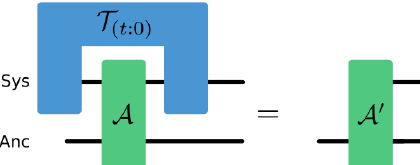
FIG. 15. Complete positivity and trace preservation for super- channels. A superchannel is said to be CP if it maps CP maps to CP maps (even when acting on only a part of them), and we call it CPTP if it maps CPTP maps to CPTP maps. Here, T ( t :0 ) is CP (CPTP) if for all CP (CPTP) maps A and all possible ancilla sizes, the resulting map A (cid:10) is also CP (CPTP). Note that for the TP part, it is already sufficient that T ( t :0 ) maps all CPTP maps on the system to a unit-trace